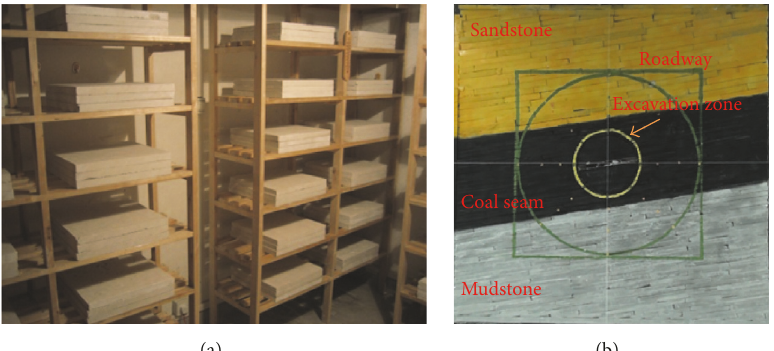
Figure 1: Pictures of elementary slabs and the physical model; (a) picture of elementary slabs made of gypsum; (b) picture of the physical model constructed completely.